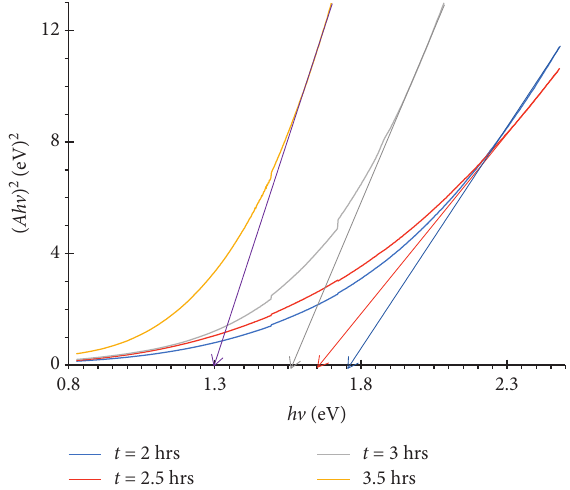
Figure 4: The band gaps of cobalt sulfide thin films obtained from the ( Ahv ) 2 vs hv plots.